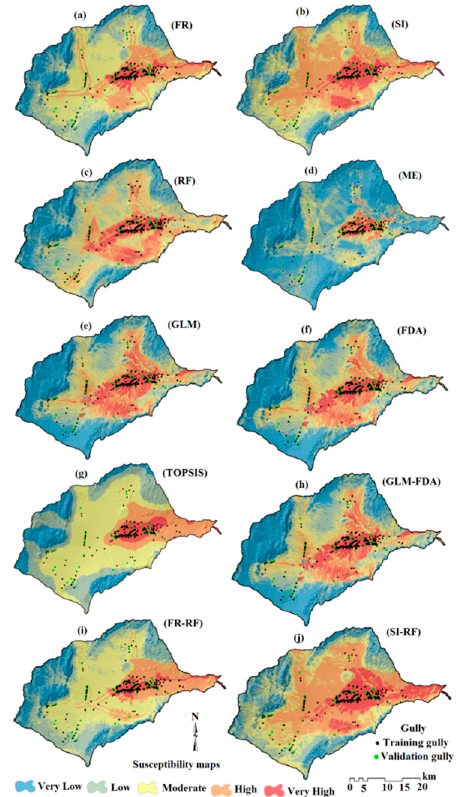
Figure 6. Gully erosion susceptibility maps. ( a ) frequency ration (FR), ( b ) statistical index (SI), ( c ) random forest (RF), ( d ) maximum entropy (ME), ( e ) generalized linear model (GLM), ( f ) functional data analysis (FDA), ( g ) TOPSIS, ( h ) GLM–FDA, ( i ) FR–RF, ( j ) SI–RF.